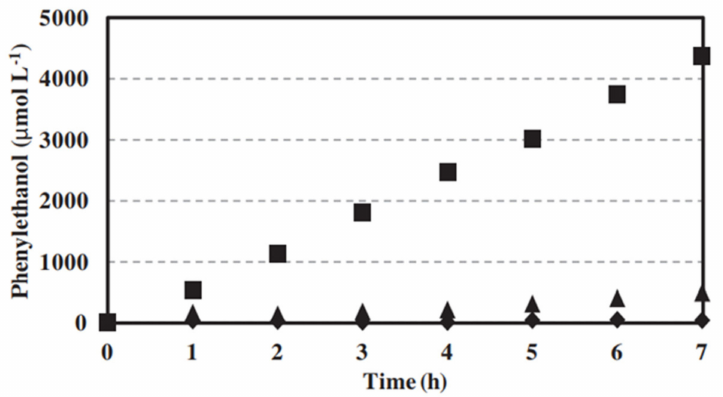
Figure 17. Phenyl ethanol extraction in the organic phase using Pd/TiO 2 and TiO 2 (under UV and visible light). Reprinted with permission from ref. [160]. Copyright © 2021 Elsevier B.V.